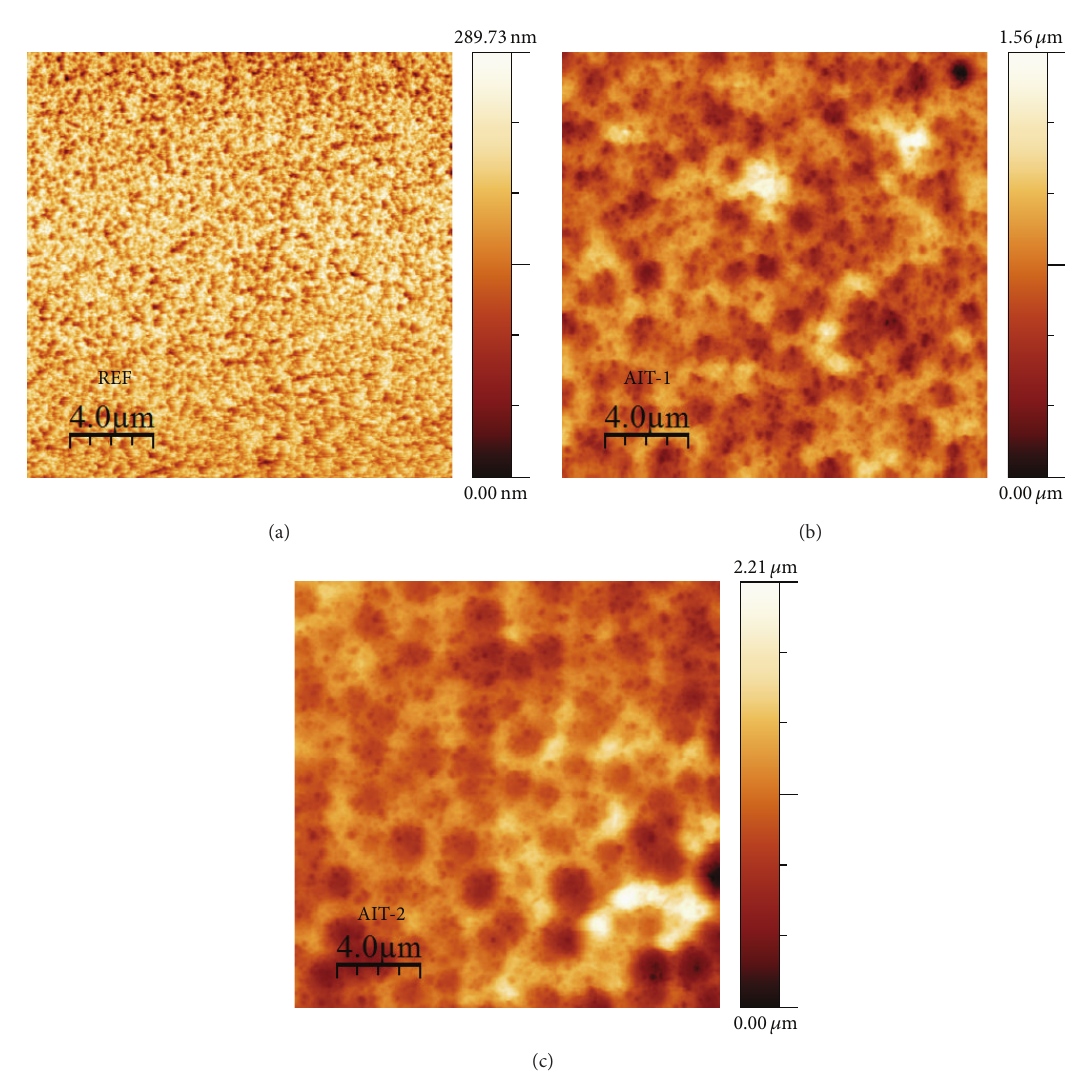
Figure 1: AFM images of the three different superstrates used in this study. (a) Planar glass superstrate covered with nanotextured TCO (reference superstrate); (b, c) microtextured AIT glass superstrate covered with nanotextured TCO. The AIT superstrate in (b) has an intermediate autocorrelation length 𝑙 (mean feature size), while that in (c) has a large autocorrelation